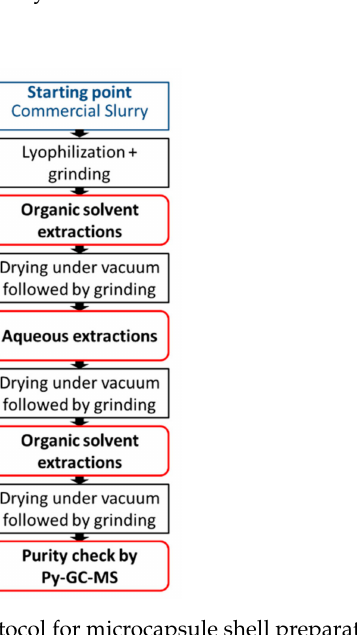
Figure 1. Extraction protocol for microcapsule shell